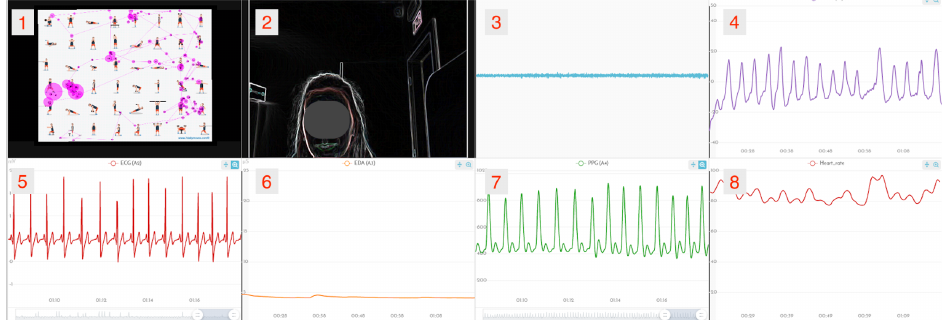
Figure 3. Psychophysiological data obtained during the experiment: ( 1 ) Eye-tracking, ( 2 ) Movement and facial expressions (Webcam), ( 3 ) Sound (Microphone), ( 4 ) PZT, ( 5 ) ECG, ( 6 ) EDA, ( 7 ) PPG, and ( 8 ) Heart Rate (HR) derived from the